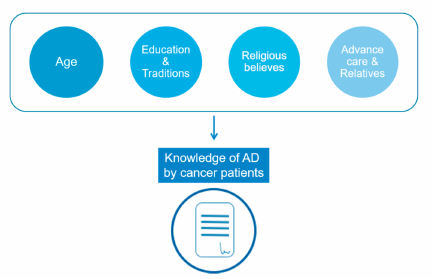
Figure 1. Main obstacles for advance directives information and use in cancer